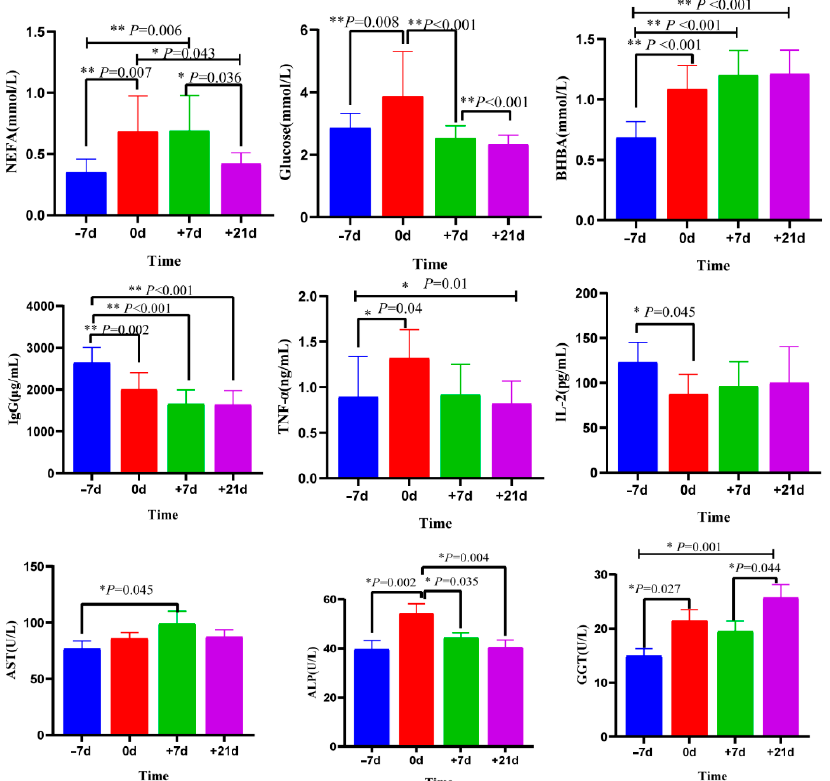
Figure 1. Plasma concentrations of non-esterified fatty acids (NEFAs), β -hydroxybutyric acid (BHBA), glucose, immunoglobulin G (IgG), tumor necrosis factor (TNF)- α , interleukin (IL)-2, AST, ALP, and GGT at − 7, 0, +7, and +21 d. Data are expressed as the mean ± SE, * represent p < 0.05; ** represent p < 0.01.